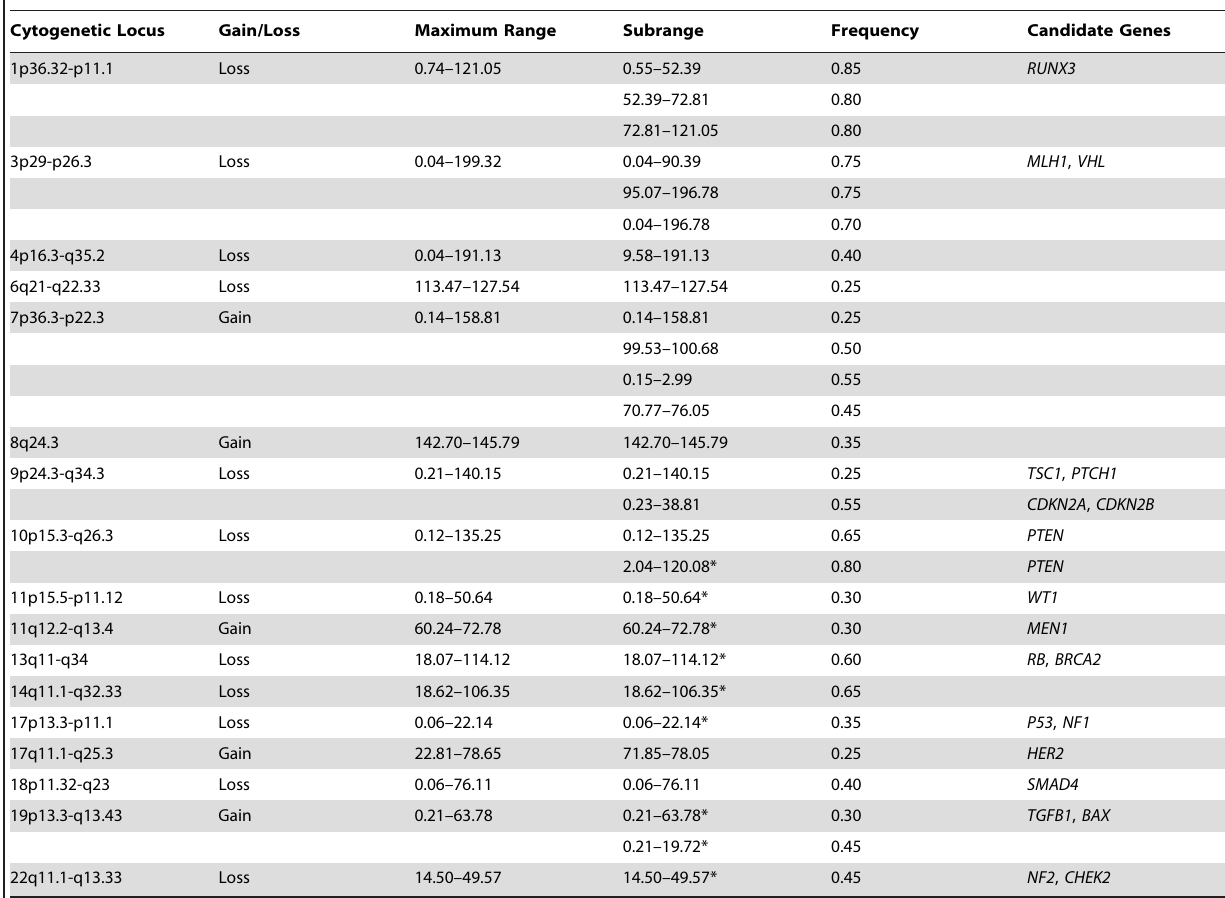
Table 2. Recurrent genomic changes in sporadic chordoma.